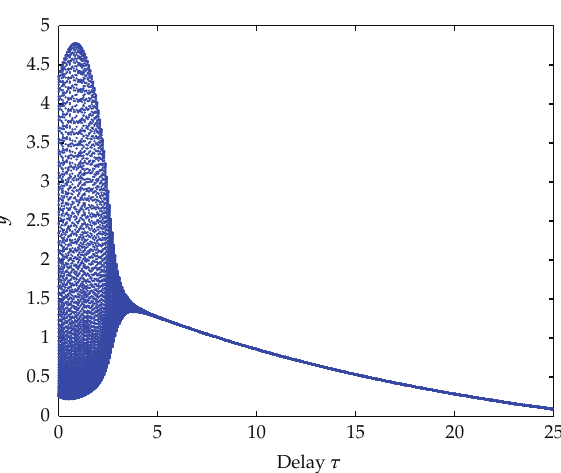
Figure 8: The relationship between ultimate oscillation range of predator and delay τ